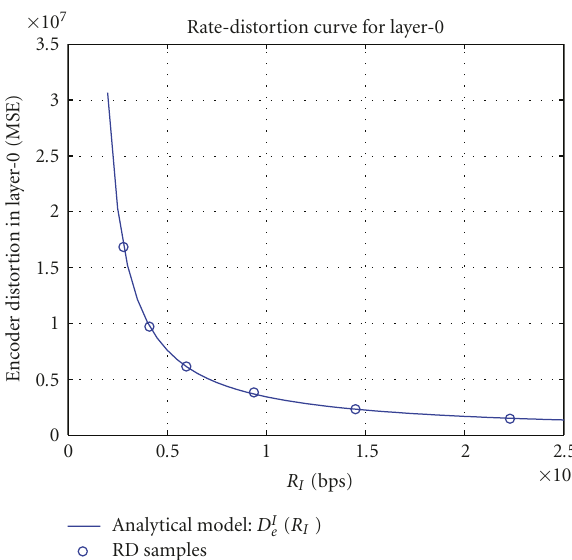
Figure 5: RD curve for layer 0 of the “Soccer” video.